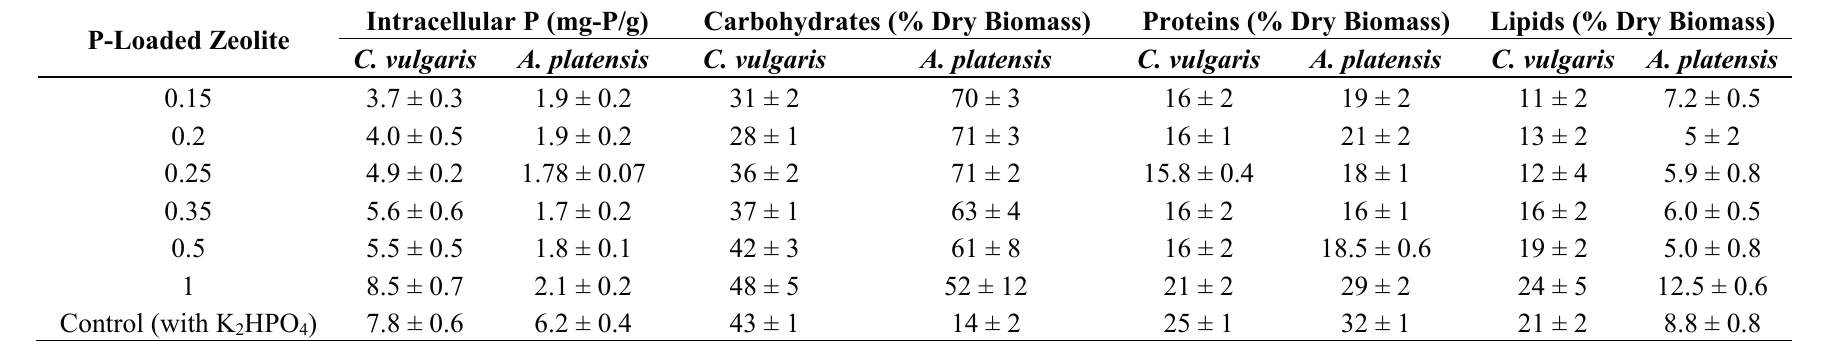
Table 1. Biochemical composition of C. vulgaris and A. platensis cultivated with 0.15–1.00 g/L P-loaded zeolite as P source.